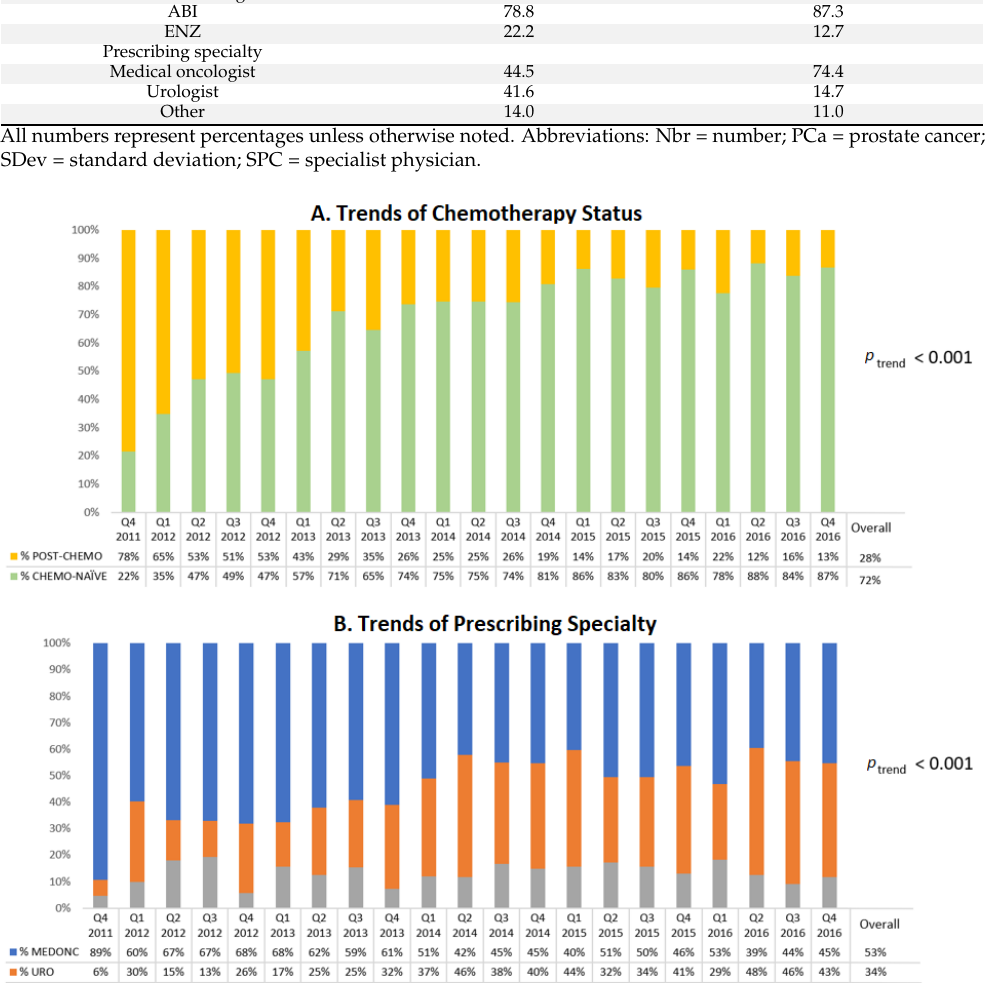
Figure 1. Overall temporal trends in initiation of novel hormonal agents from 2011 to 2016. ( A ) Strat- ified by chemotherapy status. ( B ) Stratified by prescribing specialty. fied by chemotherapy status. ( B ) Stratified by prescribing